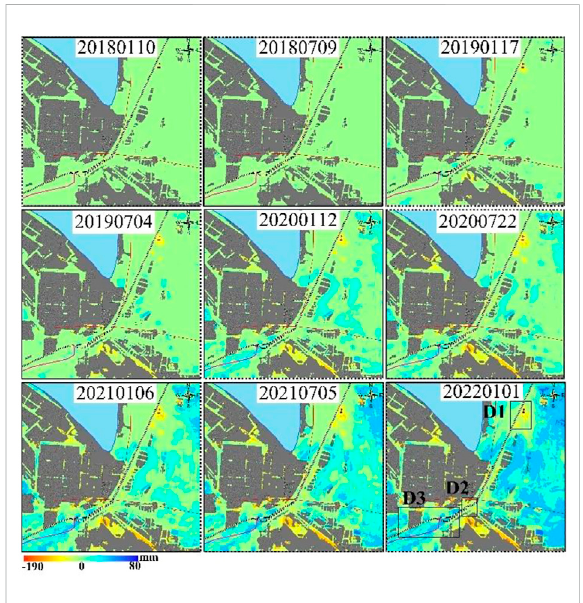
FIGURE 9 Descending accumulated deformation maps of the study segments along the QGE biannually. The red and yellow fl ags indicate the DRS and QBS. The red lines denote the faults in this